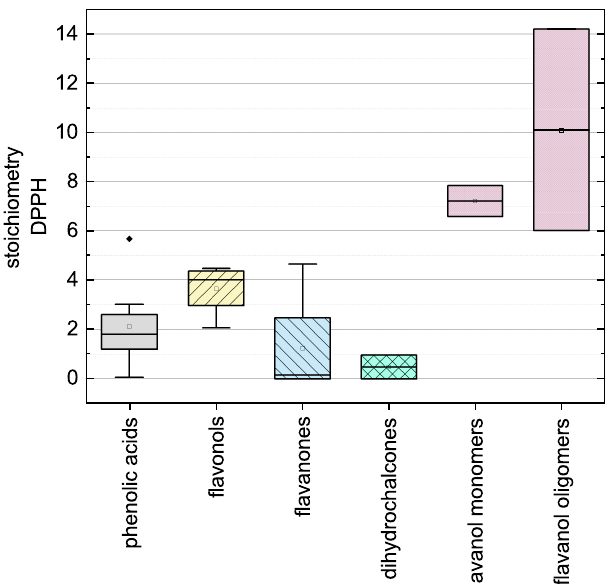
Figure 5. Boxplot of the mean stoichiometry values for subgroups of the phenolic compounds tested in the DPPH assay. Error bars represent range within 1.5 × IQR.